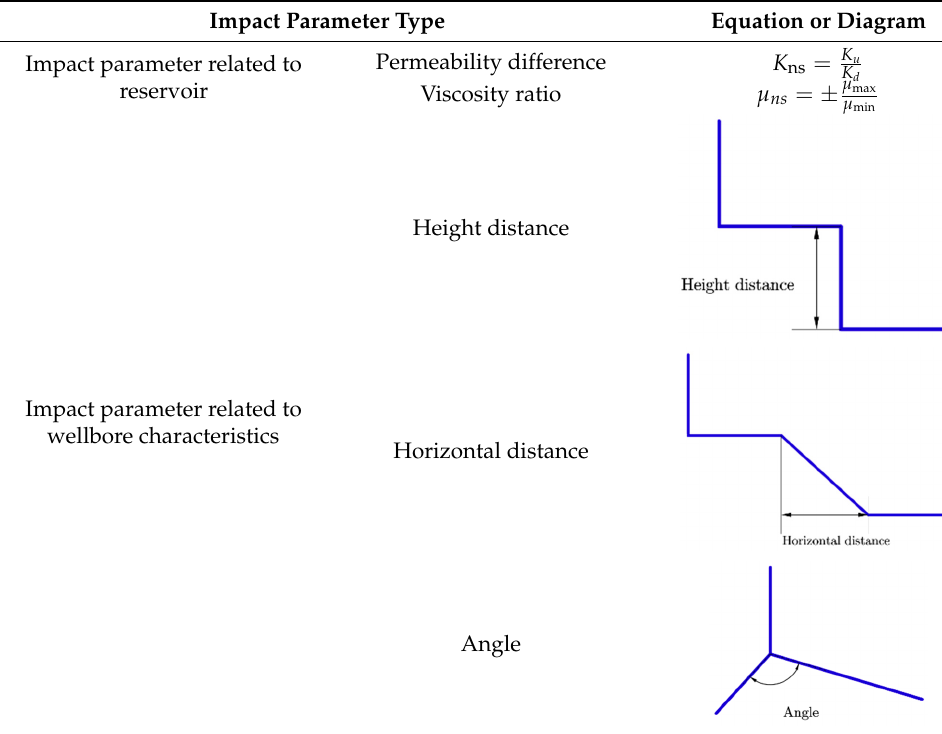
Table 7. The list of all impact parameters.